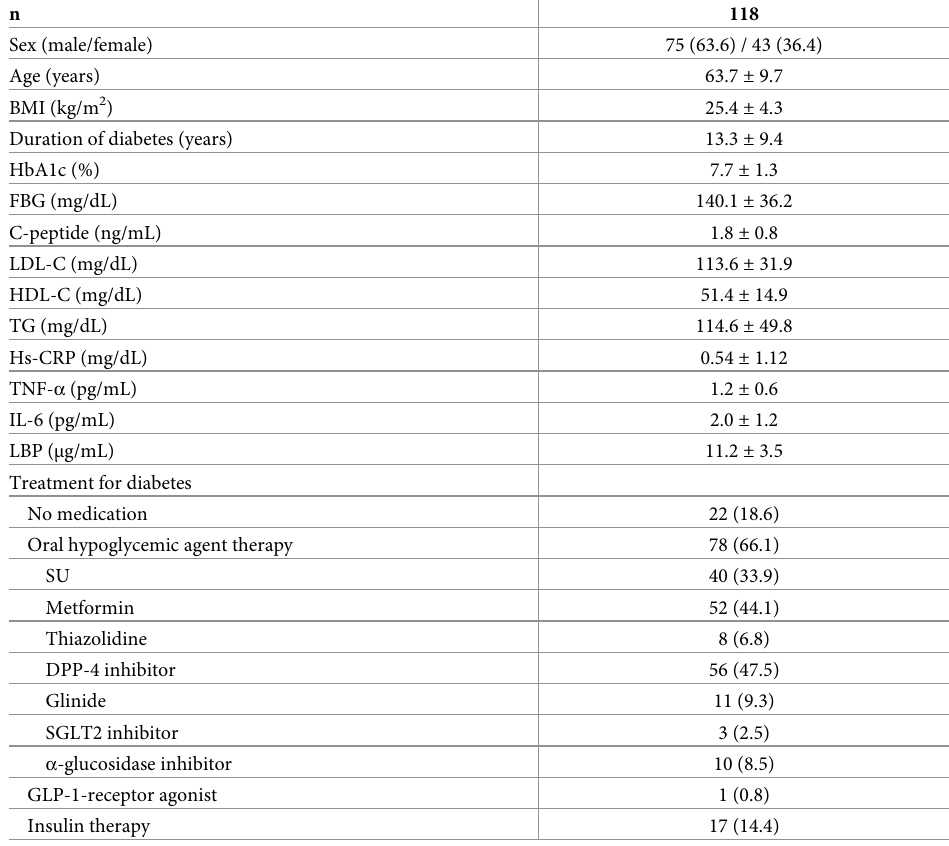
Table 1. Clinical characteristics of the study subjects.